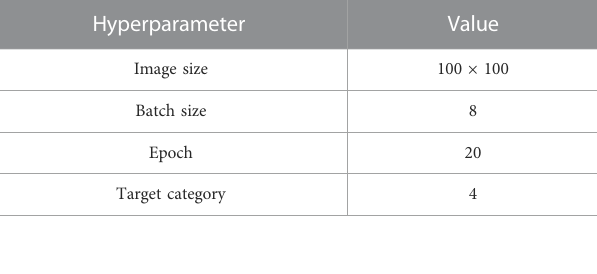
TABLE 3 Neural network training hyperparameters.